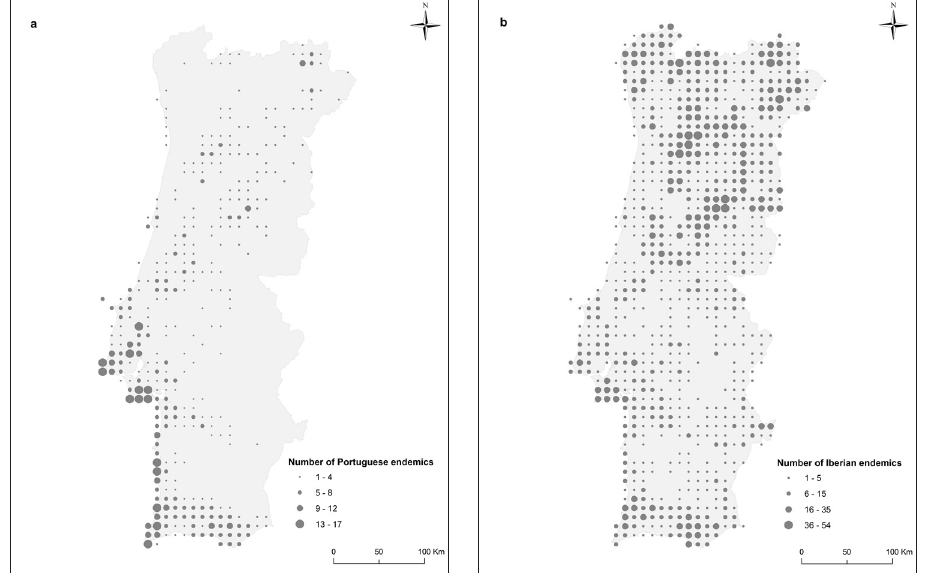
Figure 5. Number of Portuguese ( a ) and Iberian ( b ) endemic plants per 10×10 km UTM square. The dataset used in the analysis corresponds to a total of 253,310 records. Note that low values do not neces- sarily mean absence of endemic species, as many areas are under-sampled (Figure 4a). Class breaks are manual. The dots are placed at the centre of WGS84 UTM squares. N.B. Iberian endemics ( b ) do not include Portuguese